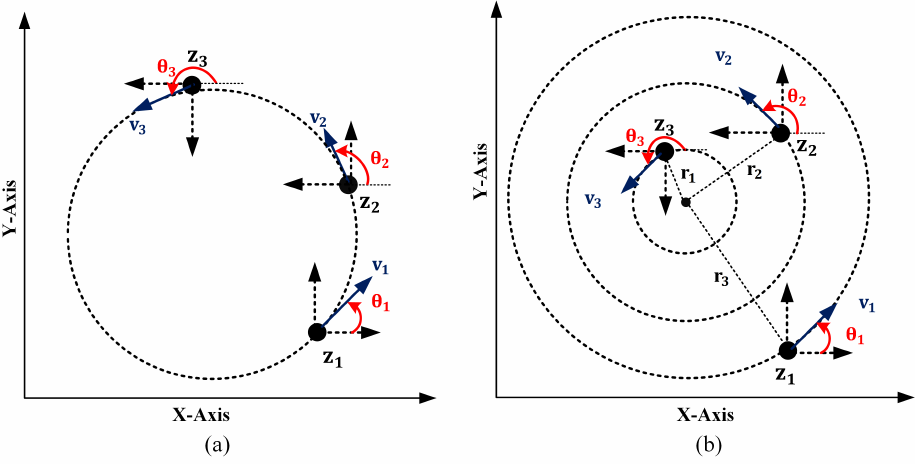
Figure 7. Collective circular motion patterns: ( a ) collective circular motion in the same radius; ( b ) collective circular motion in different